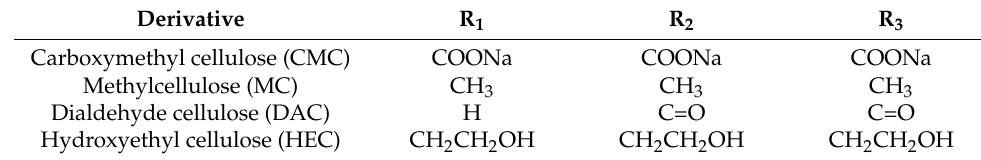
Table 2. Common cellulose